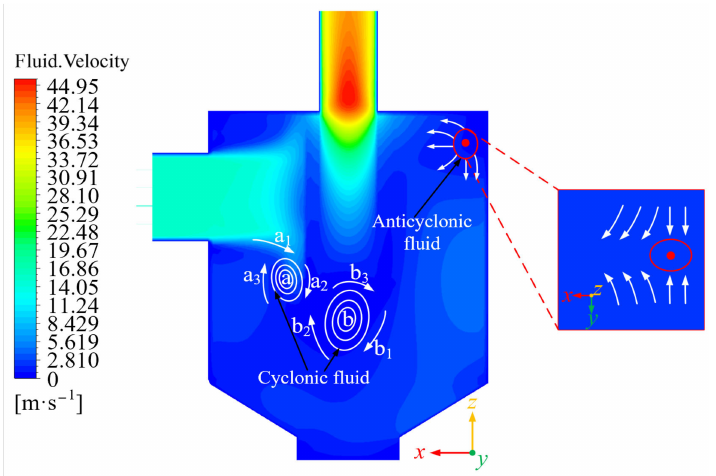
Figure 10. Velocity distribution and vortex formation